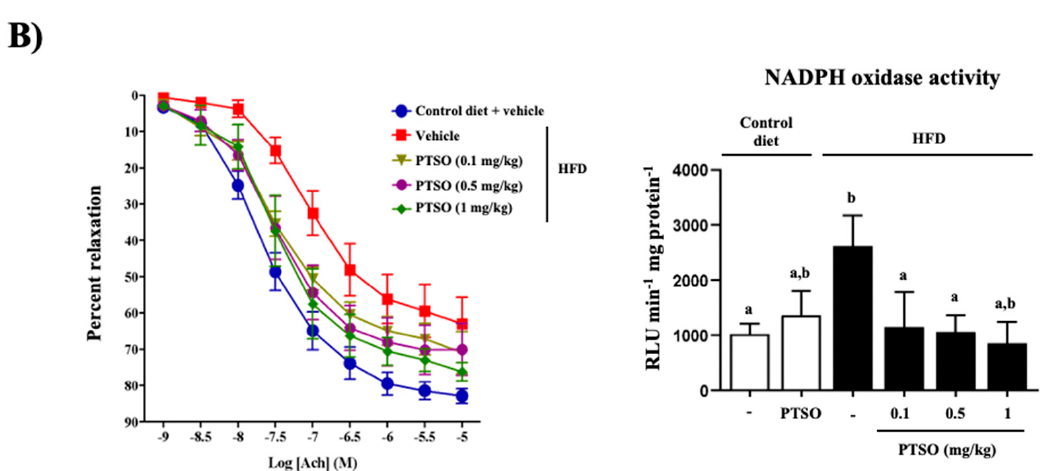
Figure 6. Effects of propyl propane thiosulfonate (PTSO) administration on ( A ) colonic gene expression of Muc-2 , Muc-3 , Occludin , Zo-1 and Tff-3 ; ( B ) endothelium-dependent relaxation and aortic NADPH activity in control and high-fat diet (HFD)-fed mice. Groups with different letters statistically differed ( p < 0.05).